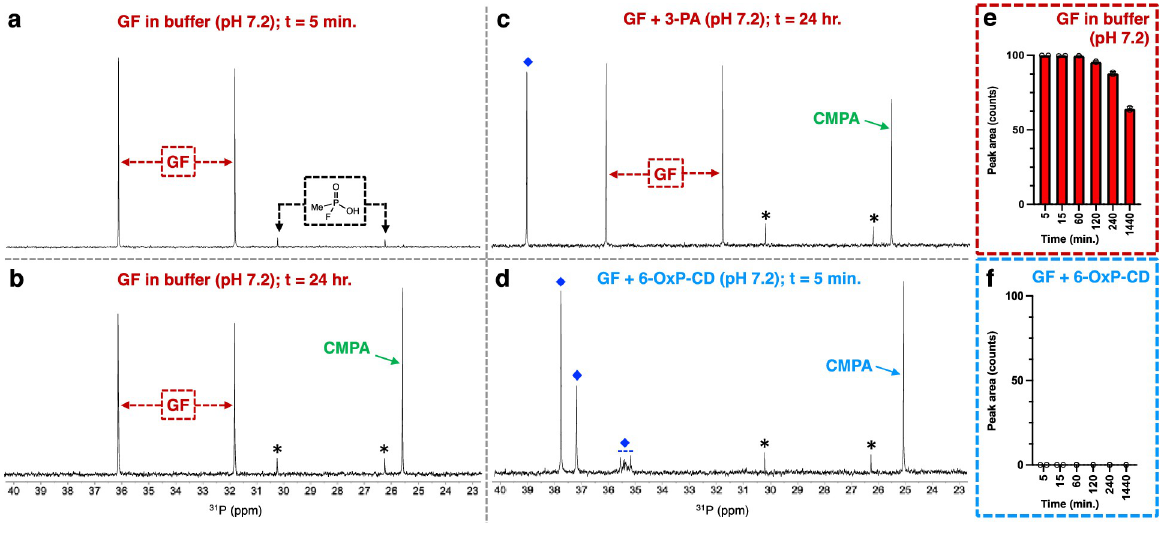
Fig 4. https://doi.org/10.1371/journal.pone.0283181.g004 Next, we turned our attention to Soman (GD) and evaluated the ability of 6-OxP-CD, β - CD and 3-PA to degrade this G-series nerve agent that poses the greatest risk among these due to its fast aging once it adducts AChE (aging t = 2 min.) [1, 70]. Fig 6A shows the 31 P-NMR 1/2 of GD at the outset of the experiment (t = 5 min.) in the buffer at 37 o C. The spectrum is domi- nated by the two sets of doublets belonging to each of the two GD diastereomers centered at δ = 34.4 ppm and 33.7 ppm each and featuring a coupling constant of J = 1045 Hz. Prolonged